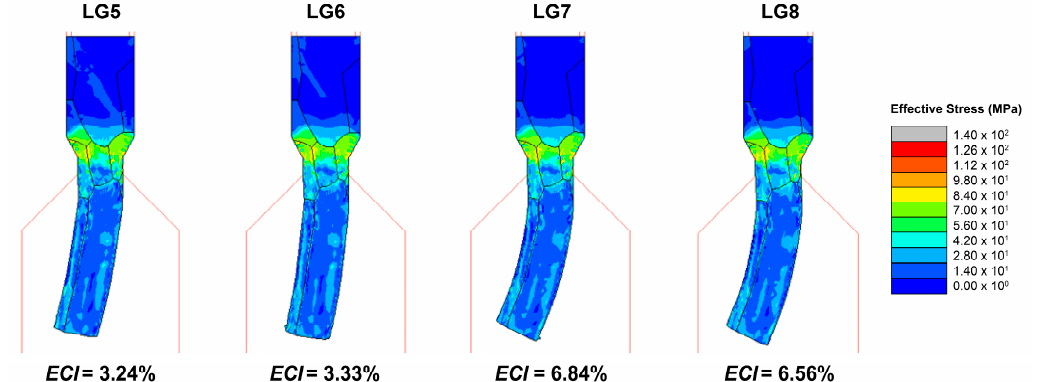
Figure 18. The micro-extrusion results of the considered conditions (LG5–LG8).